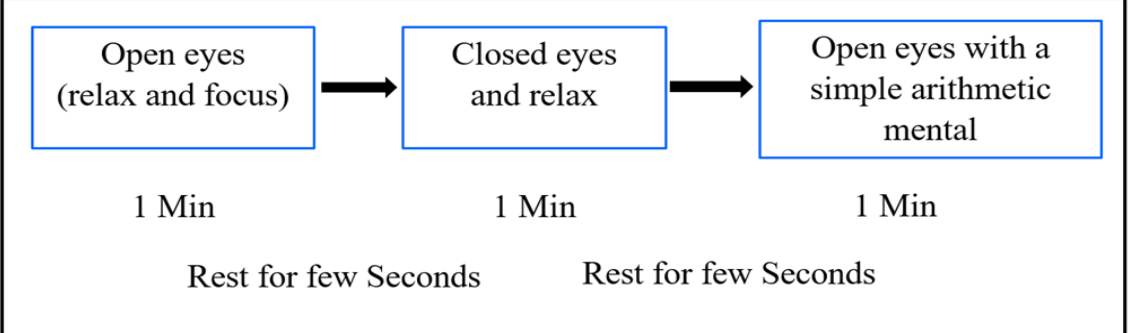
Fig. 4. The protocol of EEG signals